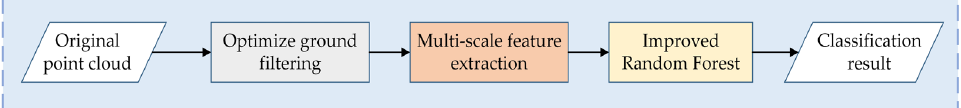
Figure 1. Overall workflow.